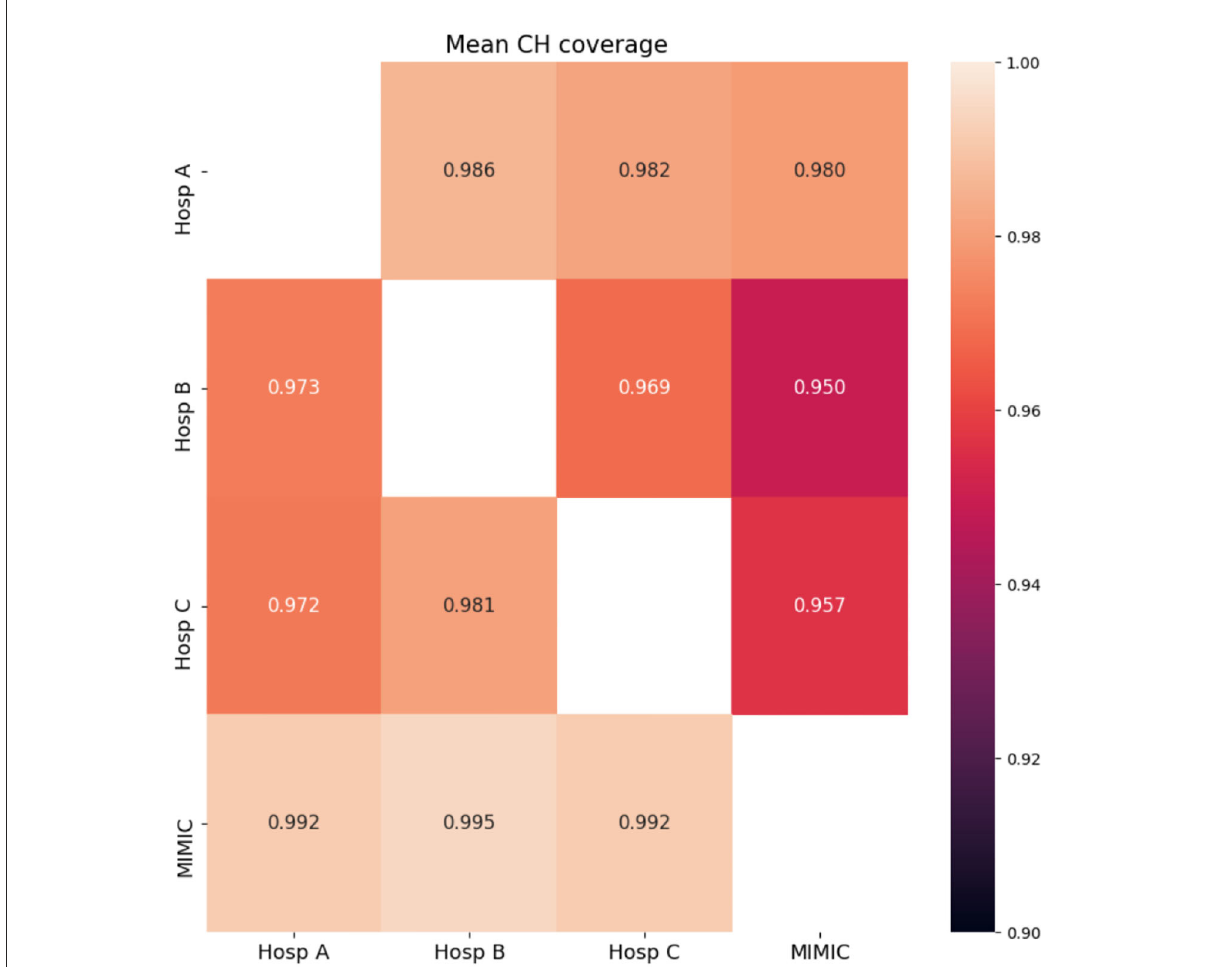
FIGURE2 CH analysis results for data from four hospitals. Mean CH coverage over all features is shown. Rows-initial population, columns-population, whose CH is covered by the CH of the initial